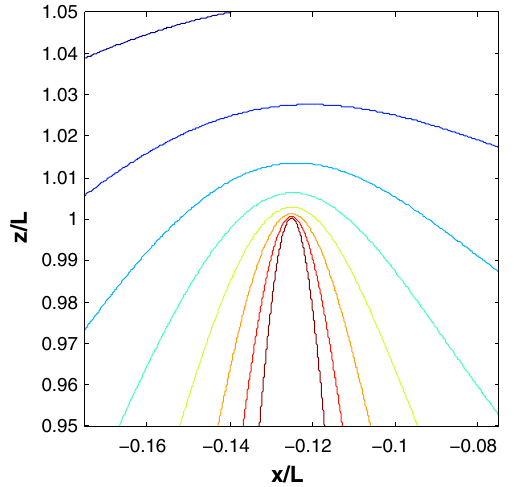
FIG. 21. Close-up of the left fiber shown in Fig. 20 and retaining the color of the contour lines shown there. The apex radius has been blunted to allow for easier visualization, but the analytic model can use any radius. Observe that the behavior matches that shown for the contour lines of Fig.